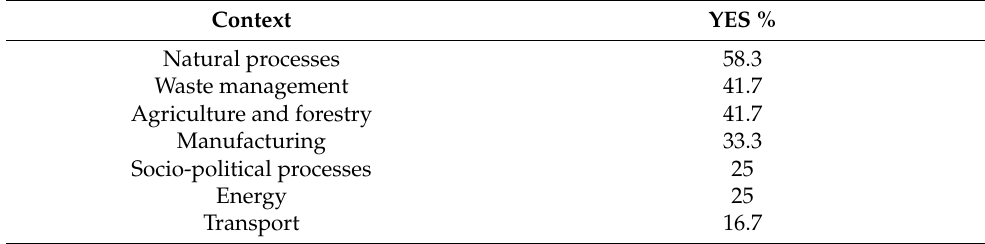
Table 9. Climate change context in parties’ pre-election programmes.